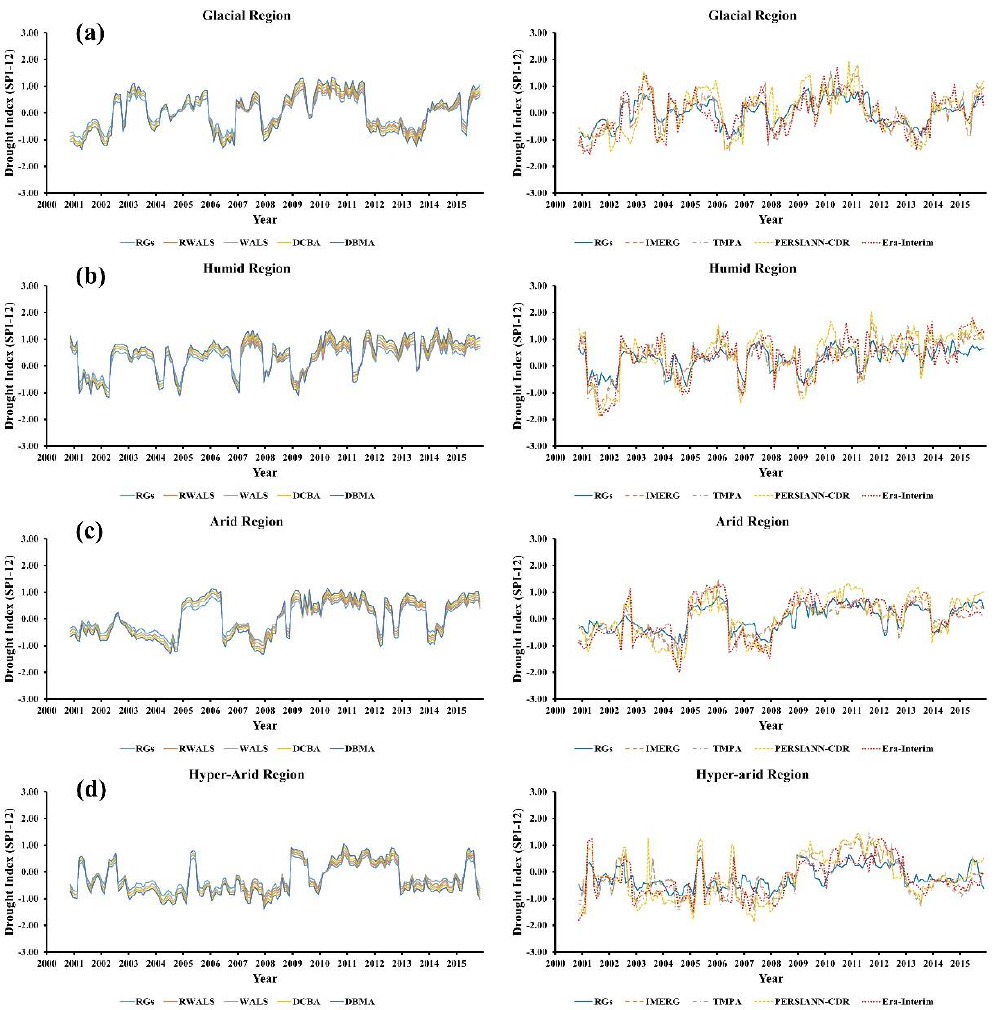
Figure 11. ( a – d ) SPI-12 drought index estimated using RGs and MSPDs ( left panel ) and SPDs ( right panel ) across all four climate regions.